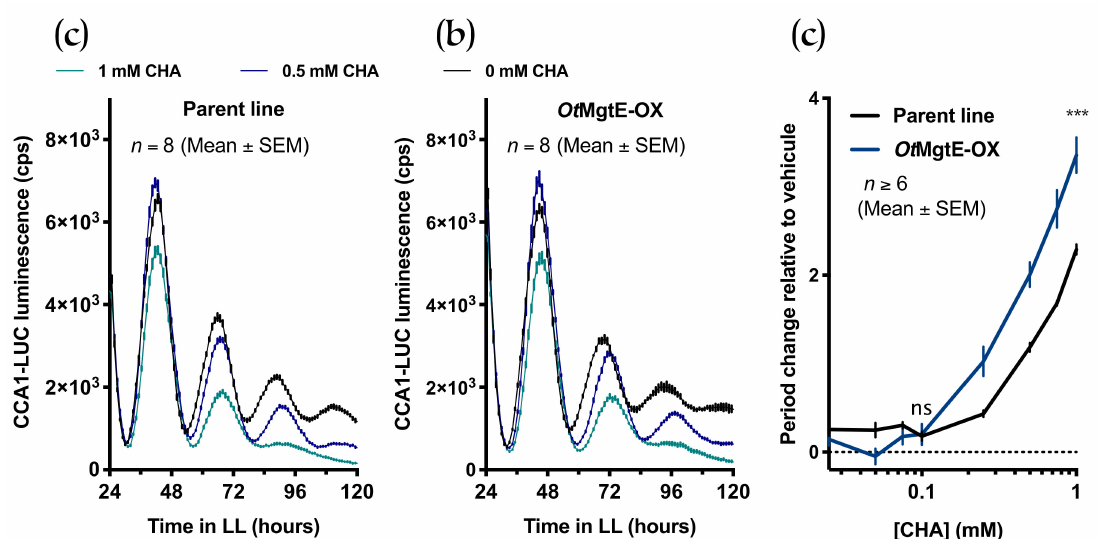
Figure 3. Overexpression of OtMgtE affects circadian period synergistically with cobalt(III)hexamine (CHA). Luminescent traces of the parent line ( a ) and Ot MgtE-OX ( b ) at certain CHA concentrations in constant light. The graph shows a line through discrete time points, at a ~1-h sampling rate (mean ± SEM). ( c ) The dose-response curve of circadian period for the parent and the OtMgtE overexpressing line at increasing concentrations of CHA. ns: p > 0.05 ***: p < 0.005; student’s t -test.